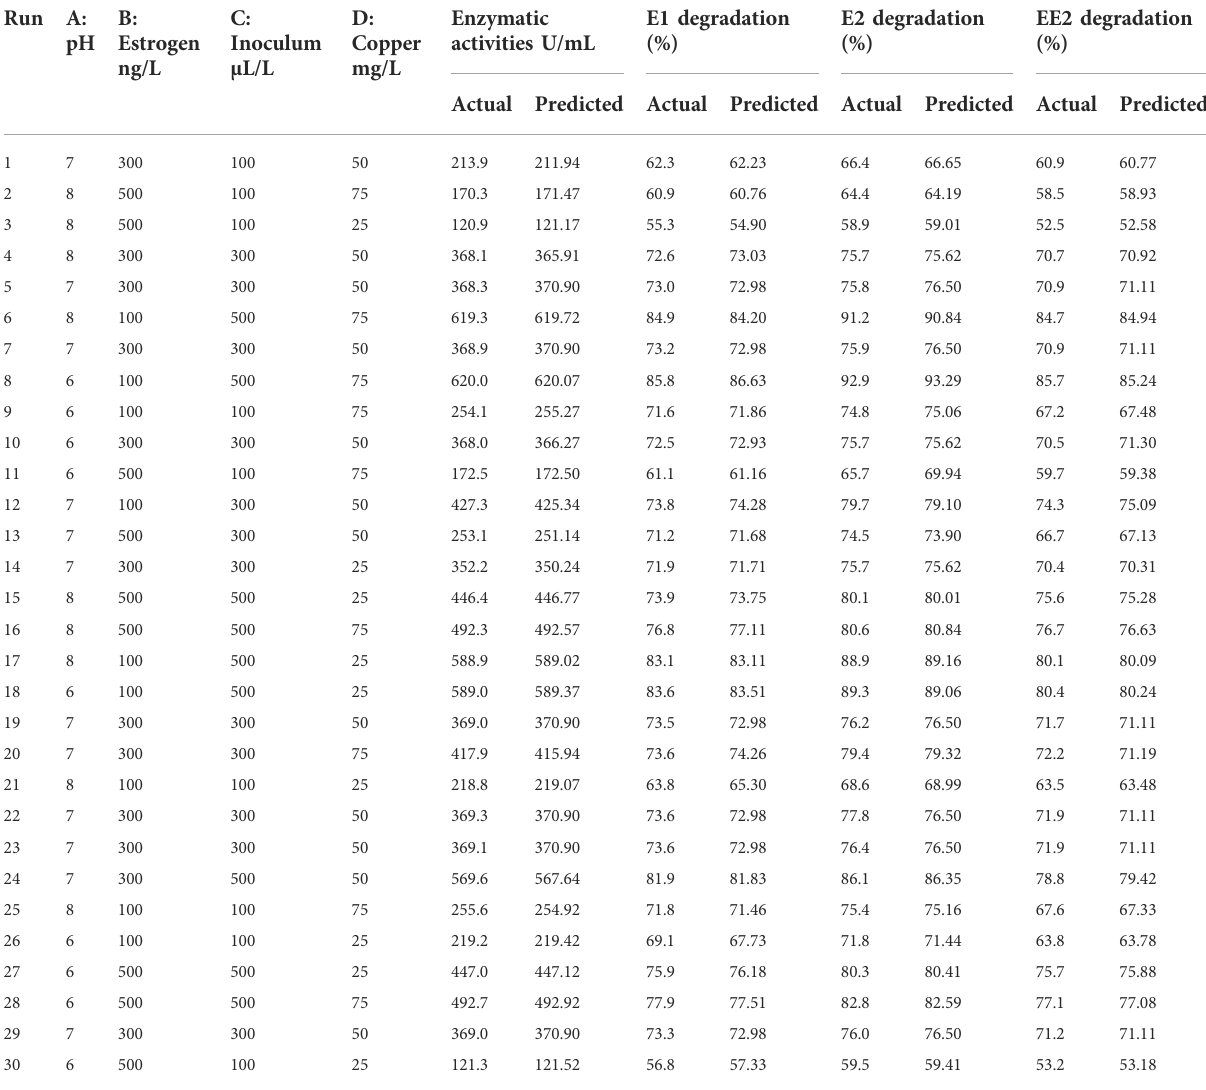
TABLE 1 CCD matrix showing actual and predicted response for Lysinibacillus sp. BP1 estrogen degradation. Run A: B: pH Estrogen